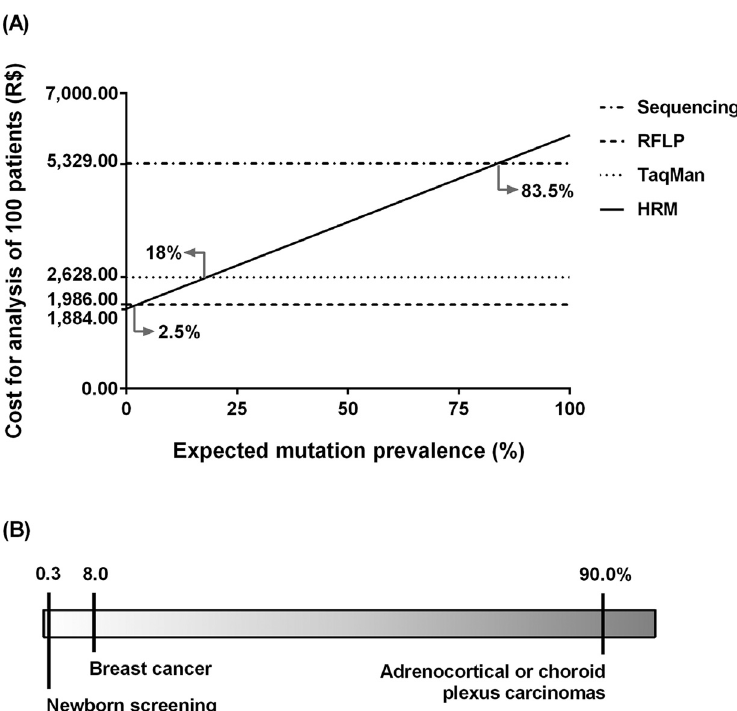
Figure 2 - Cost variation of HRM analysis for screening of the TP53 -p.R337H mutation according to estimated mutation prevalence. (A) Cost compari- son of Sanger sequencing, TaqMan-PCR and PCR-RFLP. (B) Expected mutation prevalence